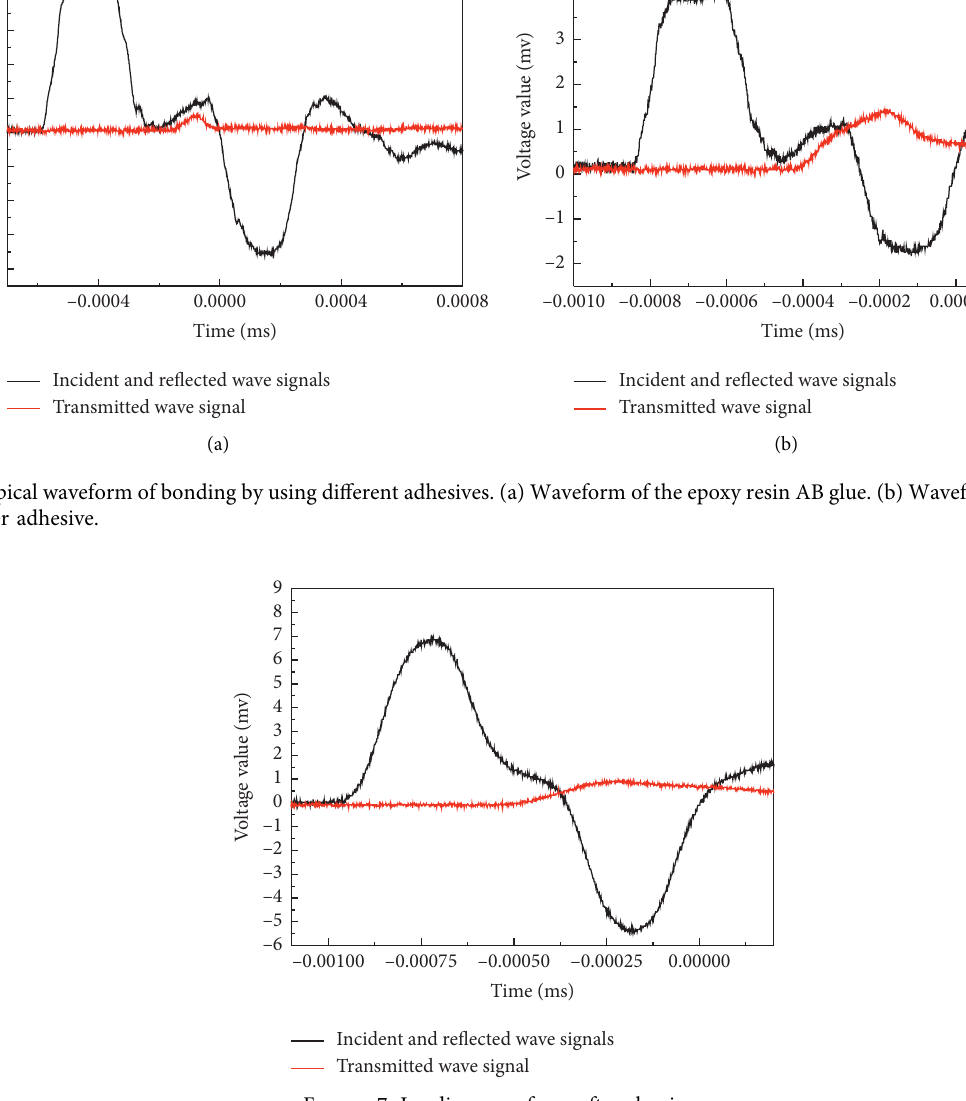
Figure 7: Loading waveform after